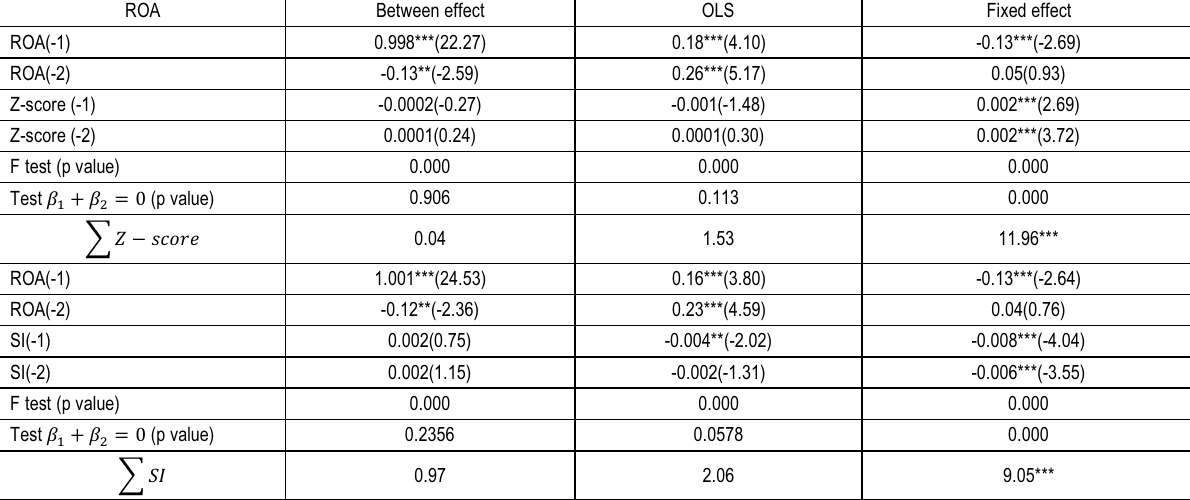
Table 6 Robustness test: impact of insolvency risk on bank profitability Between effect OLS